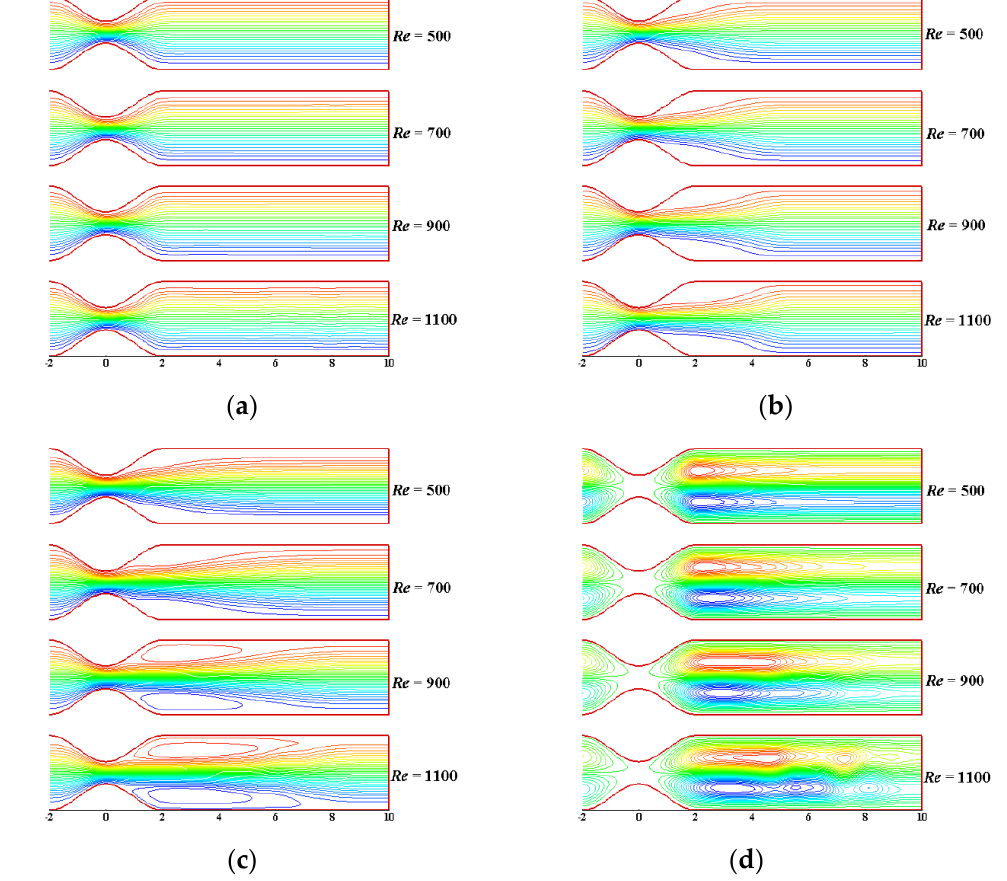
Figure 11. Streamlines of the pulsatile flow for different values of Re with M = 5, St = 0.02, and K = 0.6 at ( a ) t = 0, ( b ) t = 0.25, ( c ) t = 0.50, and ( d ) t = 0.75 .